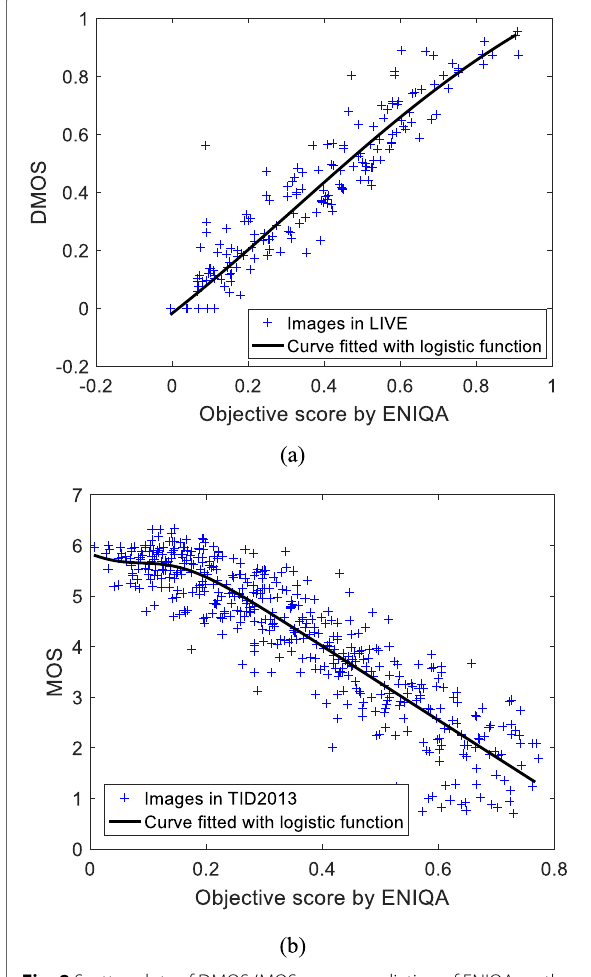
Fig. 8 Scatter plots of DMOS / MOS versus prediction of ENIQA on the LIVE and TID2013 databases. a DMOS versus prediction of ENIQA on LIVE. b MOS versus prediction of ENIQA on